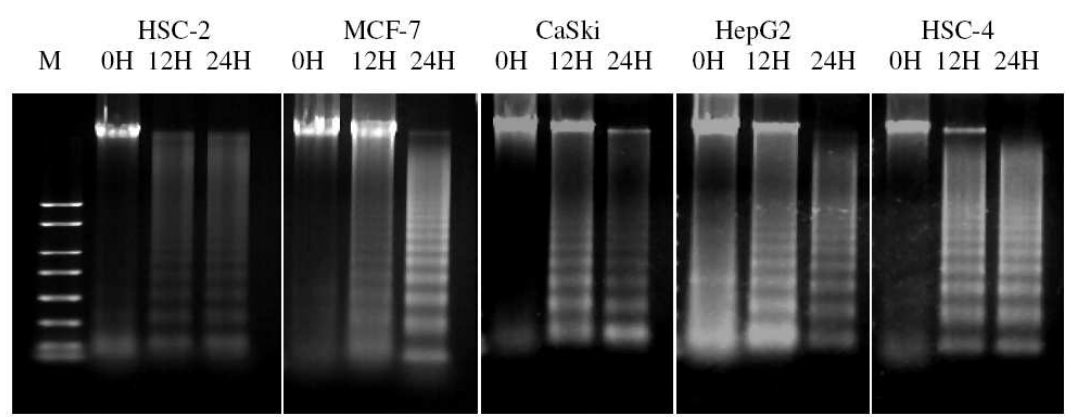
Figure 6. Confirmation of apoptosis using the DNA fragmentation assay. Cells were both untreated and treated with ACA for 12 hrs and 24 hrs to observe its effects on DNA laddering (M: 100 bp DNA Size